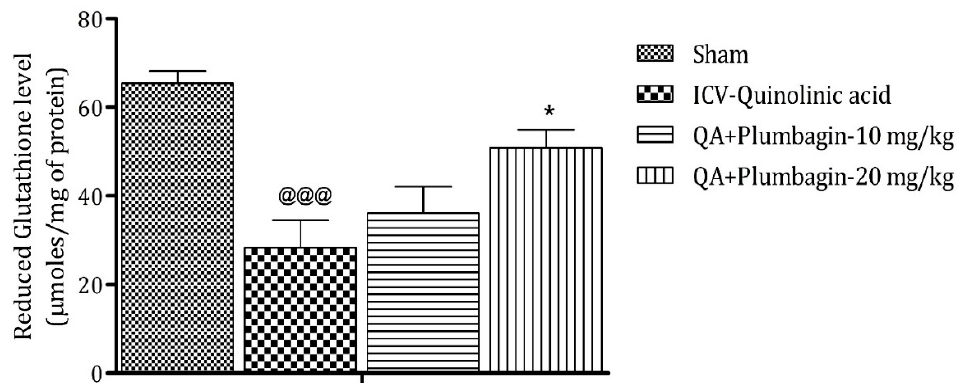
Figure 6. Effect of plumbagin on QA-induced variations in level of GSH for the determination of antioxidant activity in the rat hippocampus. Data represent mean ± SEM ( n = 6). @@@ p < 0.001 as compared to sham group; * p < 0.05 as compared to QA-induced group.